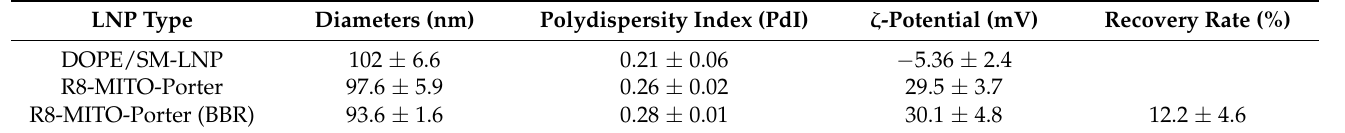
Table 1. Characteristics of the LNPs used in this study.